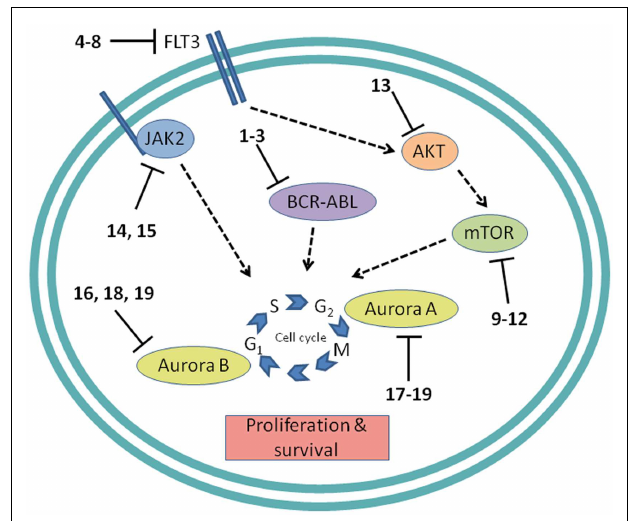
FIGURE 4 | Cell proliferation targets . Numerous interconnections between targets and other cellular proteins are omitted for clarity. Numbers in bold type refer to inhibitors shown in Figure 2